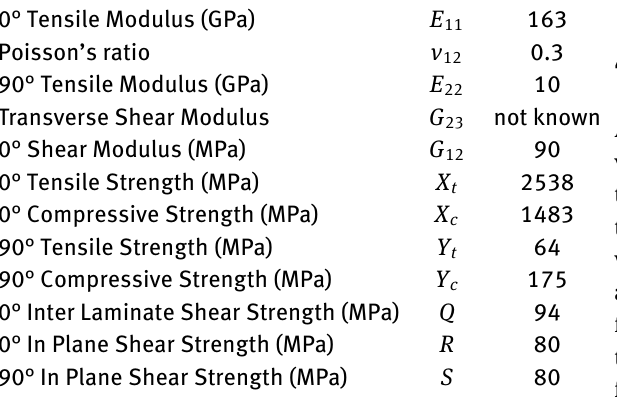
Table 1: Mechanical Properties HexPLY® IM7/8552